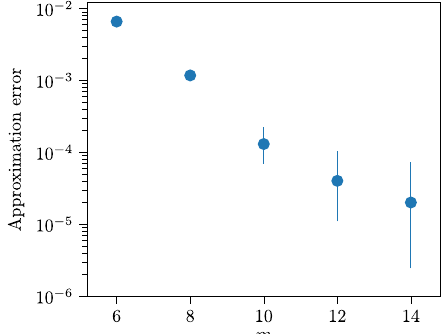
FIG. 24. The approximation error of the local matching decoder defined as the fraction of trials for which the weight of the minimum-weight perfect matching found by our local matching decoder differs from an exact minimum-weight perfect matching. We use 10 5 trials for each m , using an independent noise model with p ¼ 6% (and noiseless syndromes) for an L ¼ 30 toric code. Error bars are 95% Clopper-Pearson binomial proportion confidence intervals. For m ¼ 16 , 18, and 20, we also run 10 5 trials and find that the local matching is equivalent to exact matching for all trials.